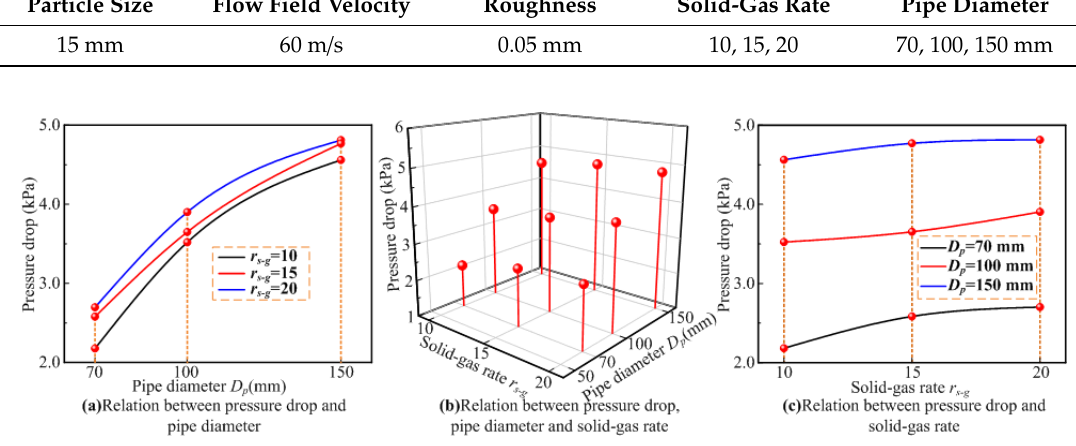
Figure 4. Relationship between pressure drop, pipe diameter and solid-gas rate.